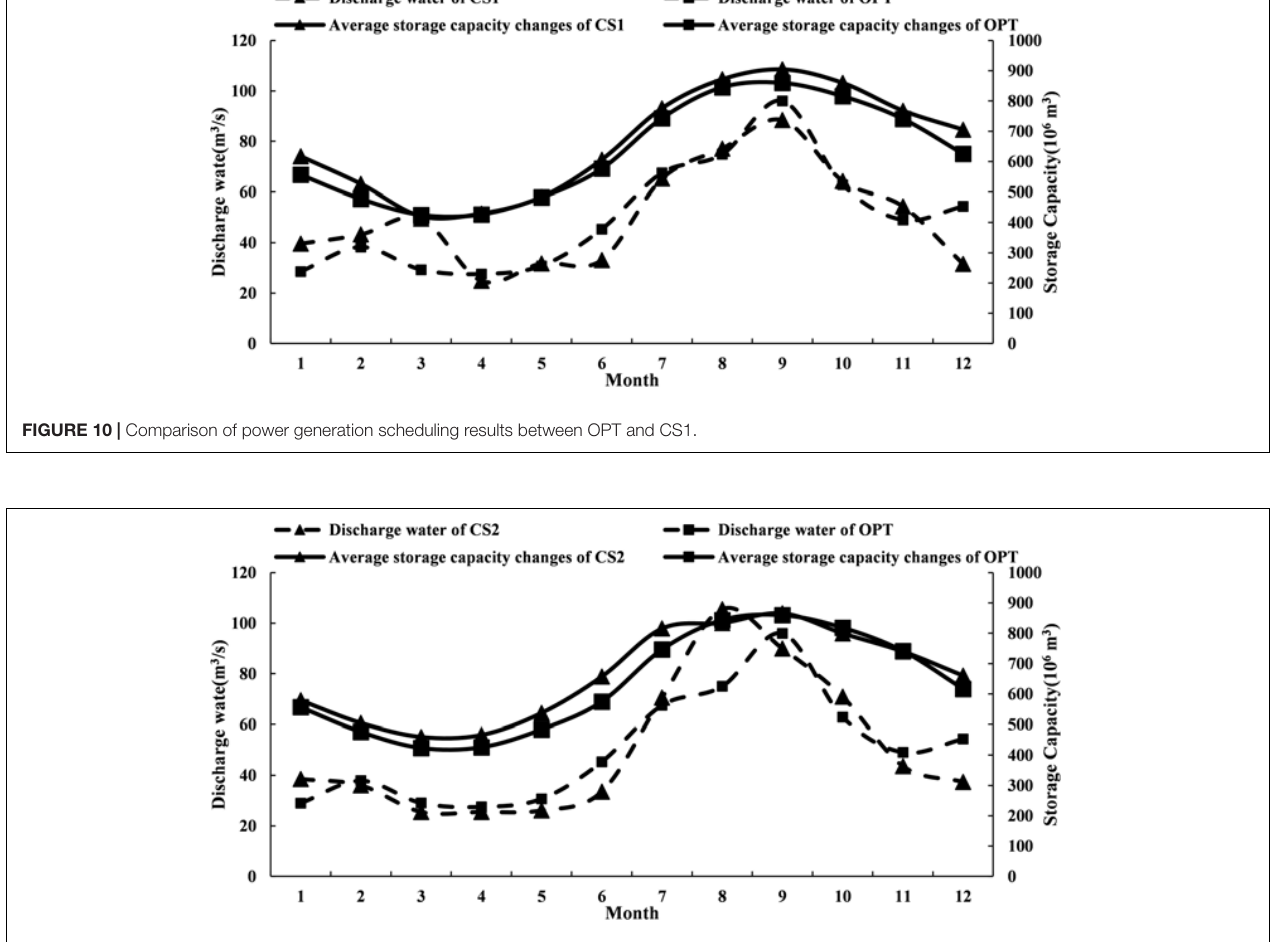
FIGURE 11 | Comparison of power generation scheduling results between OPT and